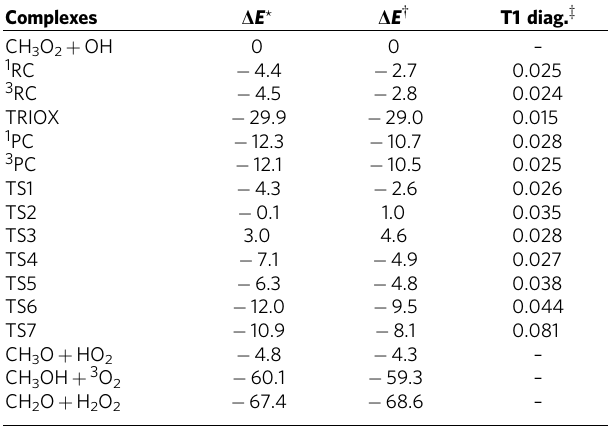
*Computed at M06-2X-D3/6-311 þ þ G(3df, 3pd) level of theory. w Computed at CCSD(T)-F12/cc-pVTZ-F12//M06-2X-D3/6-311 þþ G(3df, 3pd) level of theory. z T1 diagnostic for CCSD(T)-F12 calculations.